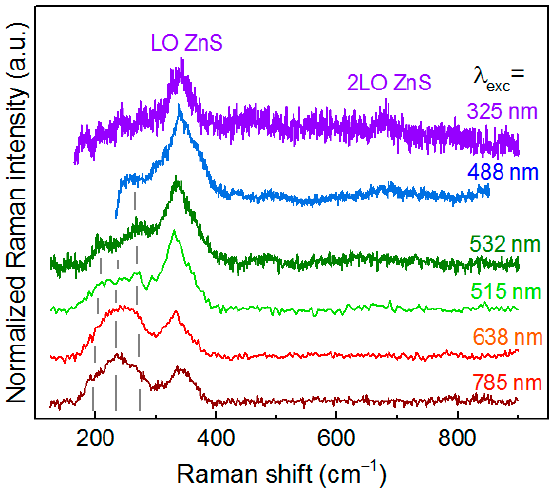
Figure 8. Raman spectra of typical AZTS NCs at different λ exc .